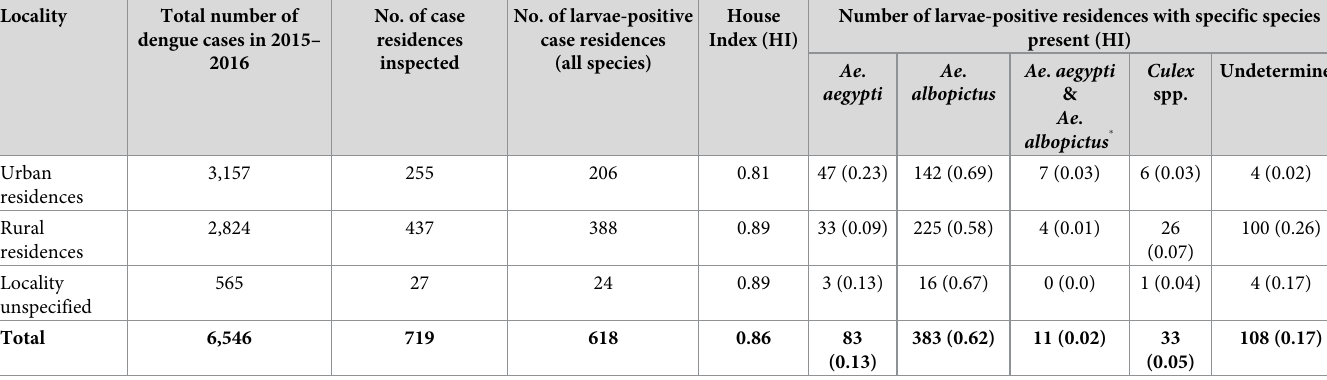
Table 2. Mosquito larvae species collected from case residences in Sabah during 2015–2016.